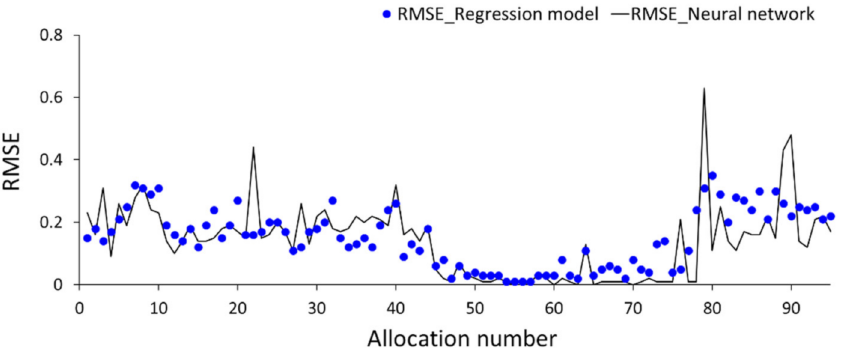
Figure 9. RMSE versus allocation number.